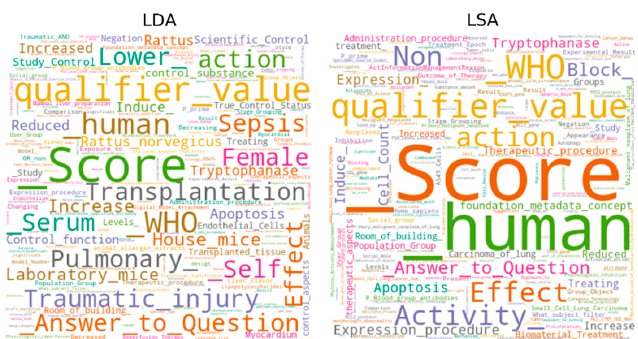
Figure 4. Word cloud of the top-1 topics on the RCD hallmark.